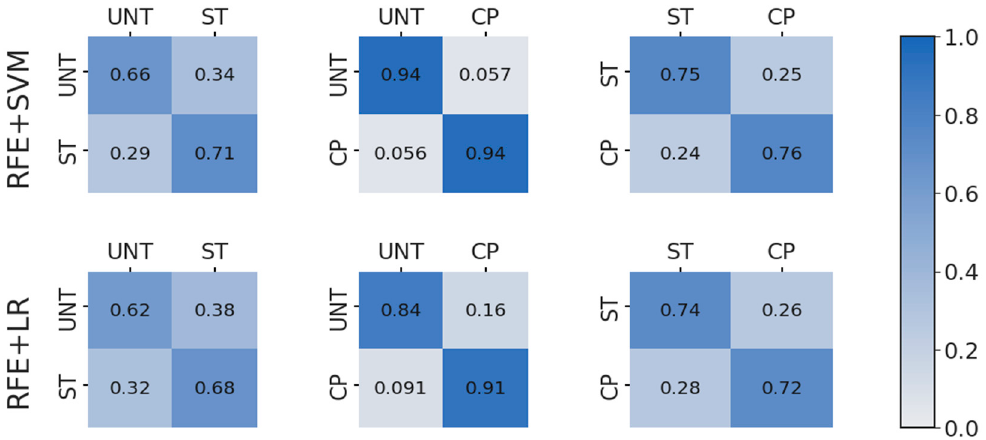
Figure A2. Confusion matrices showing actual ( y -axis) with predicted ( x -axis) class for each binary class pair with recursive feature elimination (RFE) combined with either support vector machine (SVM) or logistic regression (LR) classifiers.